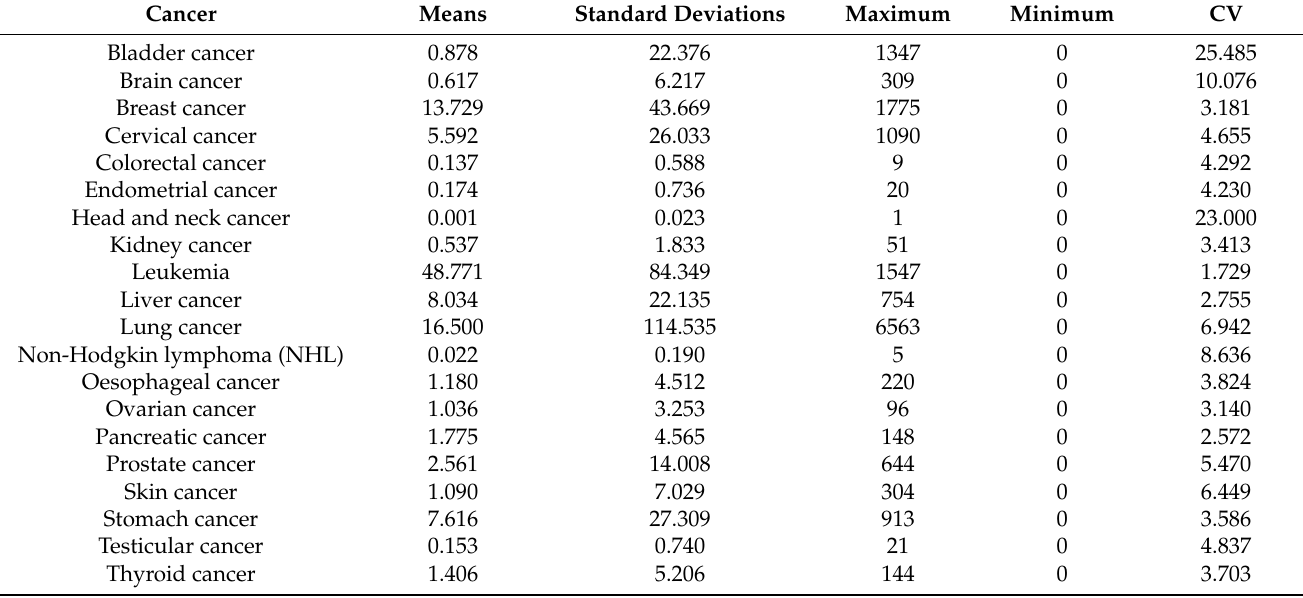
Table 2. Descriptive information of 20 cancers’ Baidu Media